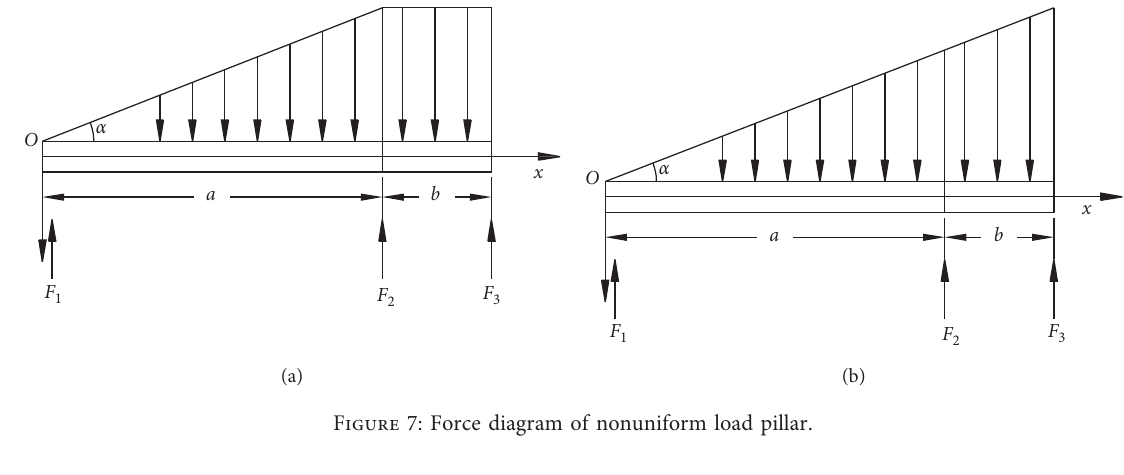
Figure 7: Force diagram of nonuniform load